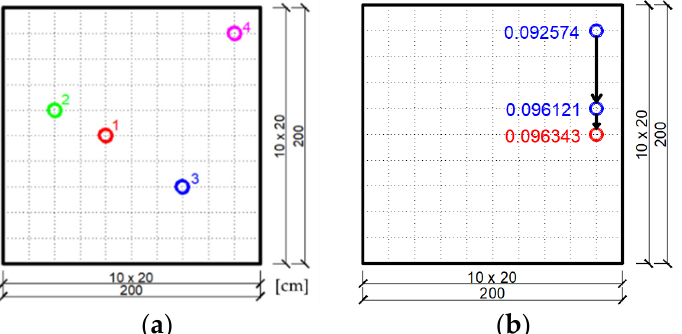
Figure 4. The adopted neighborhoods in the plate for swarm particles: ( a ) One neighborhood on the entire surface of the plate; ( b ) Four neighborhoods for the individual quarters of the plate.